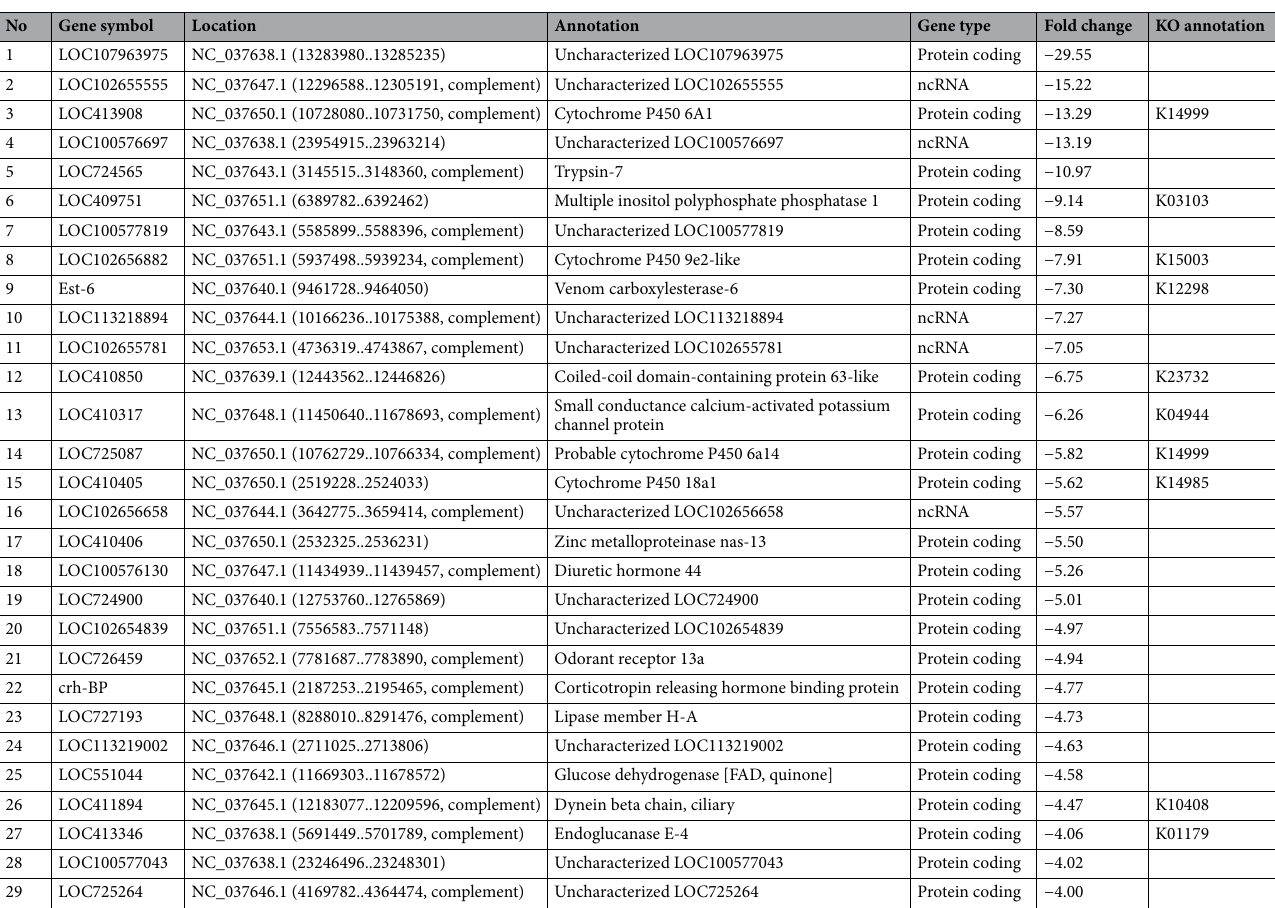
Table 2. List of downregulated genes (fold change ≤ − 4) identified in the DWV-infected honey bee larvae